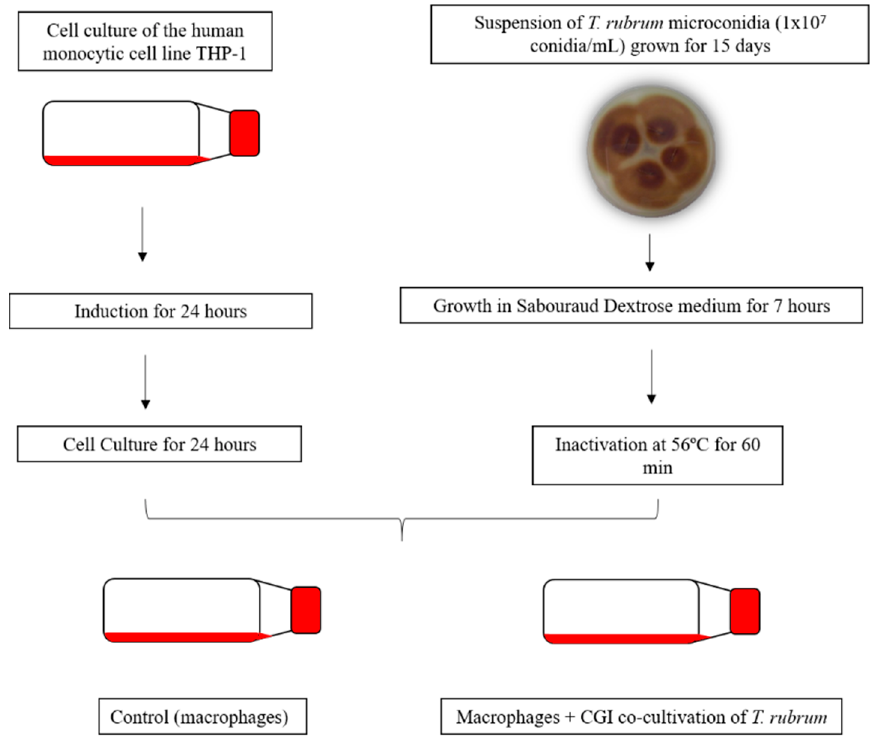
Figure 1. Flow diagram of macrophages and conidia germinated and heat-inactivated (CGI) of T. rubrum co-cultivation.